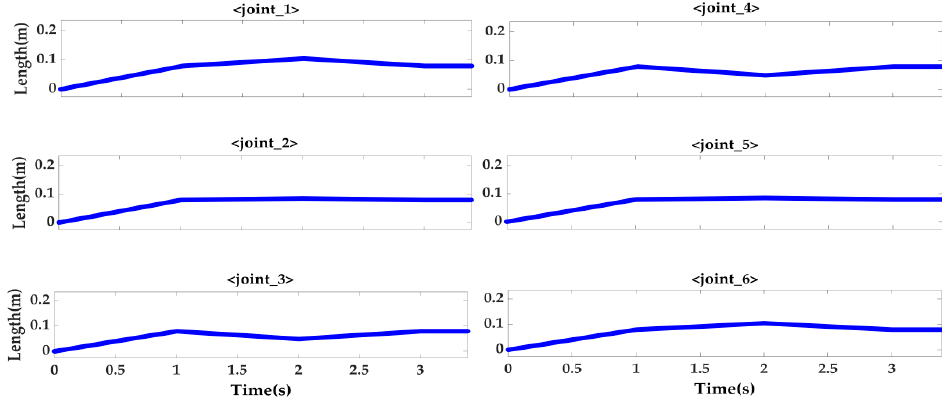
Figure 17. Electric cylinder displacement curve.